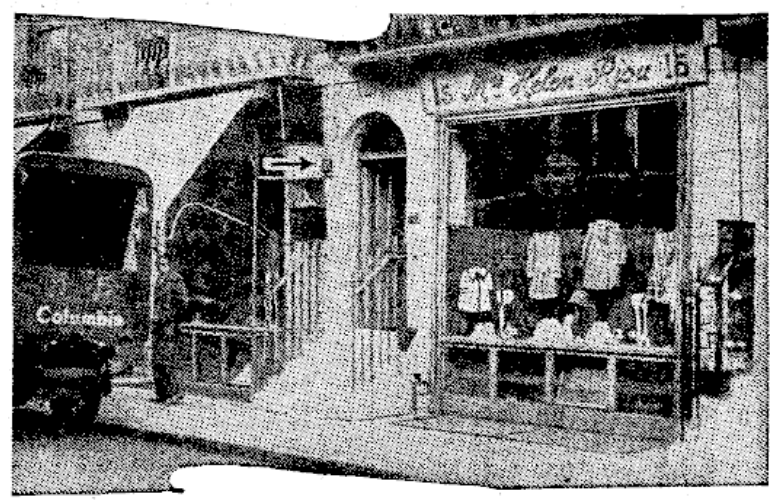
Figure 11. Aldgate—microphone location.